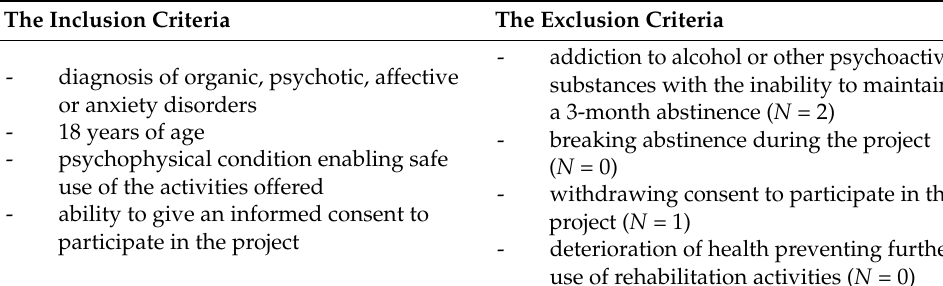
Table 2. Inclusion and exclusion